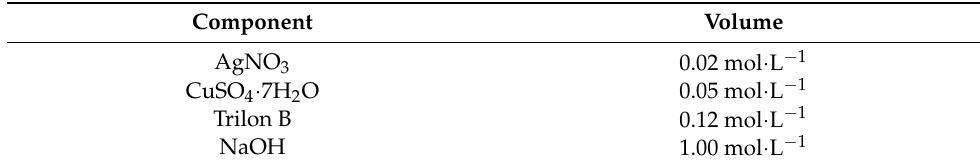
Table 1. Composition of the mixture applied for catalyst deposition (Cu-Ag alloy).